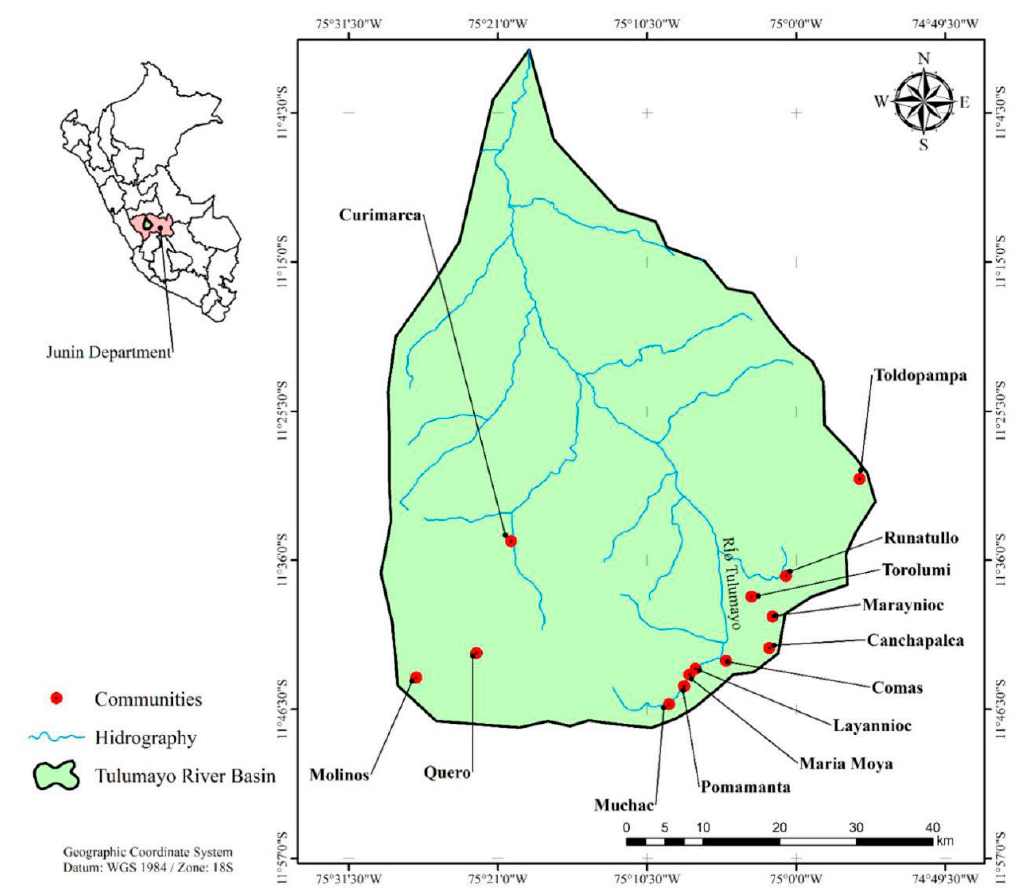
Figure 2. Location of the selected rural communities in the Tulumayo River Hydrographic Basin, Junin Department, Central Andes of Peru. Elaboration: Luciano Cavalcante de Jesus França. Source: GEO GPS PER Ú